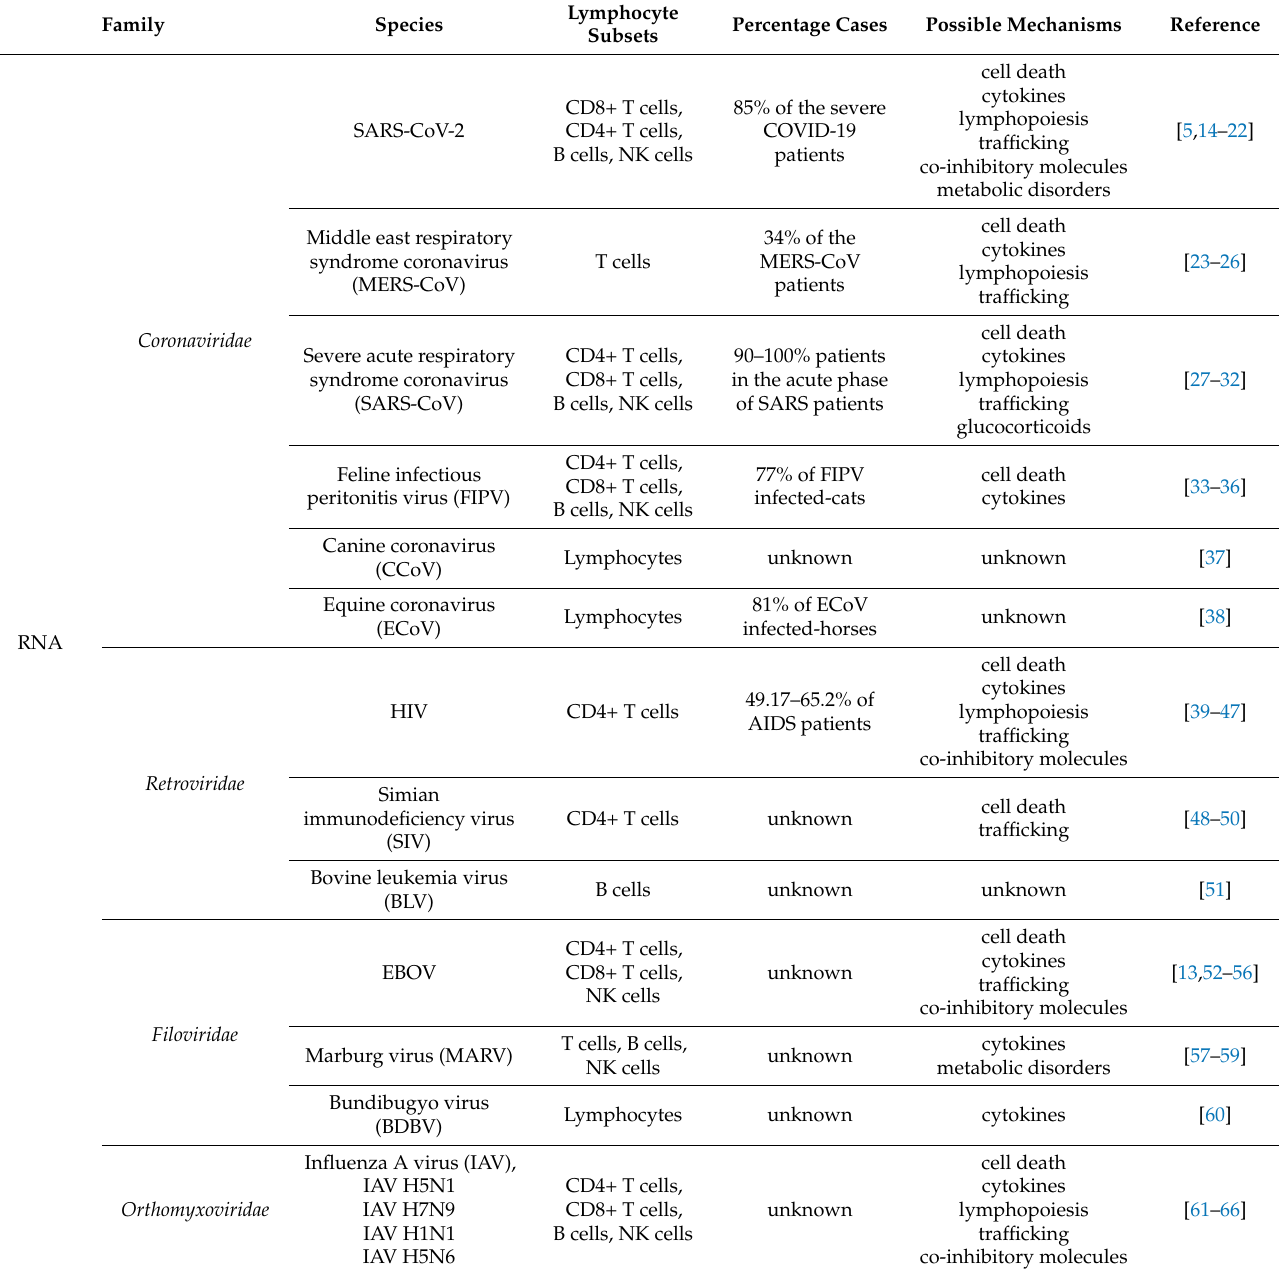
Table 1. Lymphopenia caused by viral infections and the possible mechanisms involved.